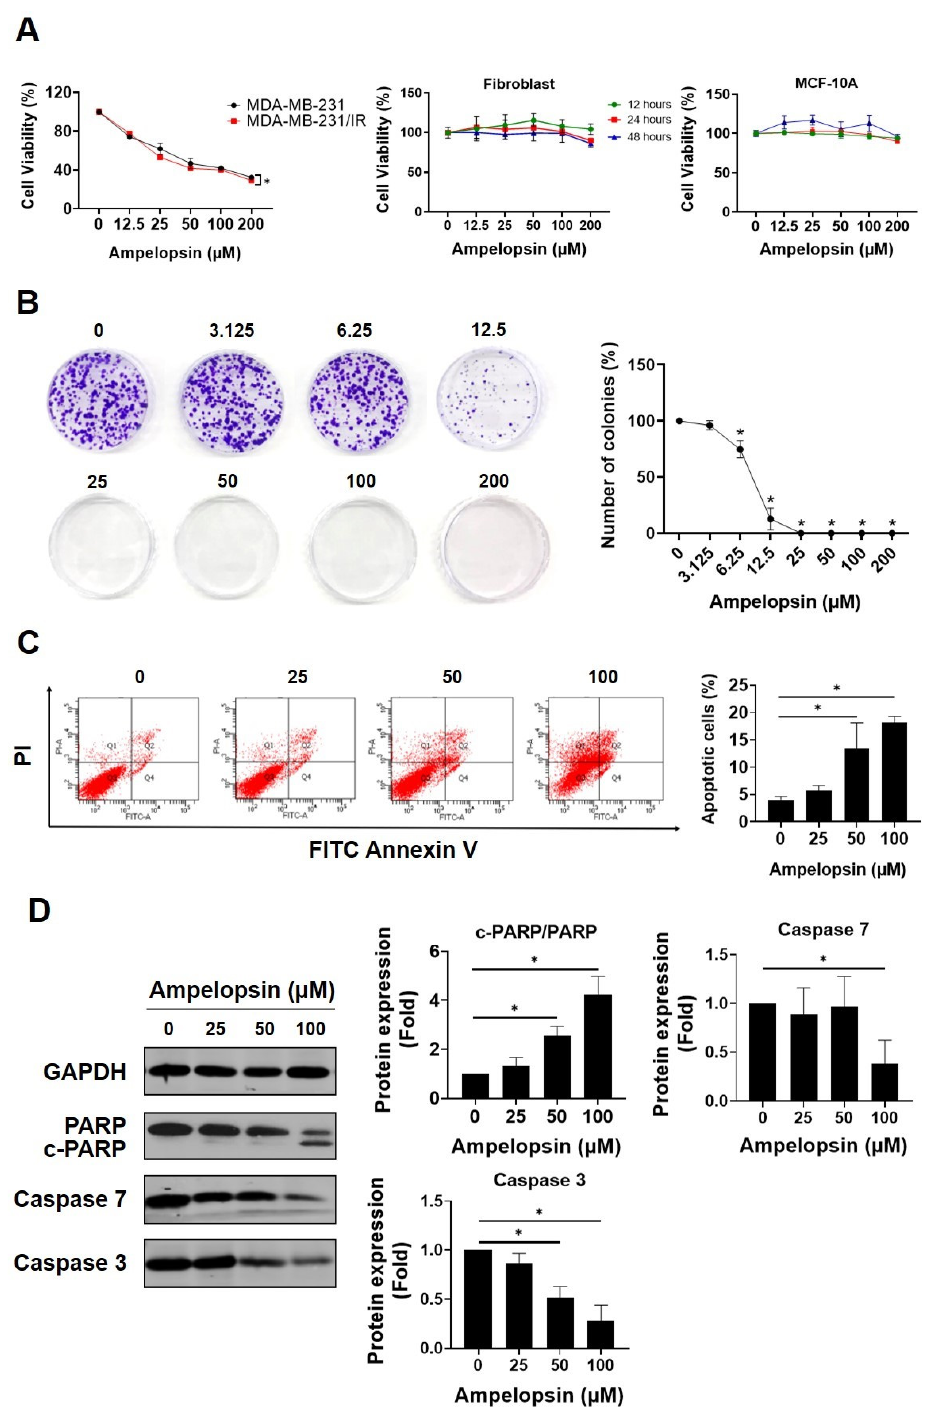
Figure 1. Ampelopsin exerts cytotoxicity in MDA-MB-231/IR cells. ( A ) The cell viability was measured by MTT assay after ampelopsin exposure for 24 h in MDA-MB-231 and MDA-MB-231/IR cells or fibroblast cells and the mammary epithelial cells, MCF-10A, in dose- and time-dependent manners. ( B ) Colony formation assay of cells treated with ampelopsin after 10 days of incubation. ( C ) Annexin V vs. propidium iodide (PI) staining was conducted to measure the apoptotic population by FACS analysis, following treatment with ampelopsin for 24 h. ( D ) Western blotting analysis of apoptosis markers following ampelopsin treatment. GAPDH was used as the loading control. Original films were shown in Figure S3. * p < 0.05 vs.